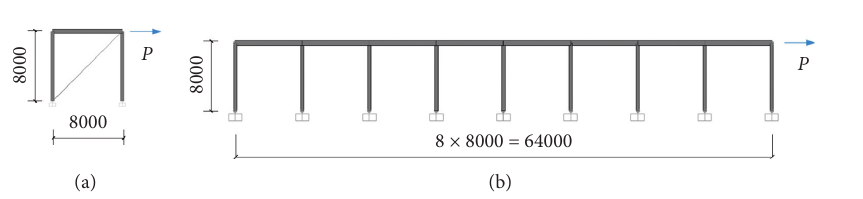
Figure 13: Pushover models. (a) Steel structure; (b) RC structure.